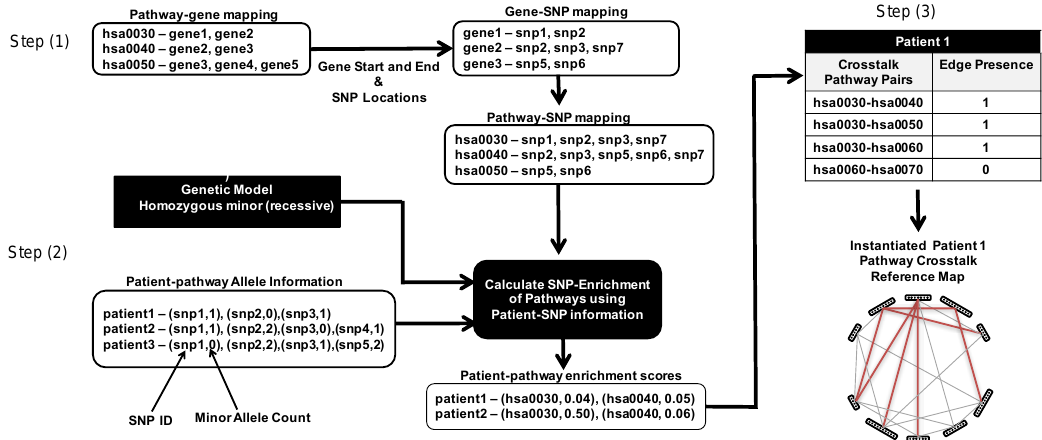
Figure 2. Identification of patient-specific pathway crosstalks. The methodology has three steps: ( 1 ) mapping the Single Nucleotide Polymorphisms (SNPs) to genes and in turn to pathways using the SNP and gene location information, ( 2 ) choosing a genetic model and calculating a patient-specific SNP enrichment score for each pathway using the patient’s allele information, and ( 3 ) overlaying the pathway enrichment scores on the reference crosstalk map to build patient-specific pathway crosstalk maps.